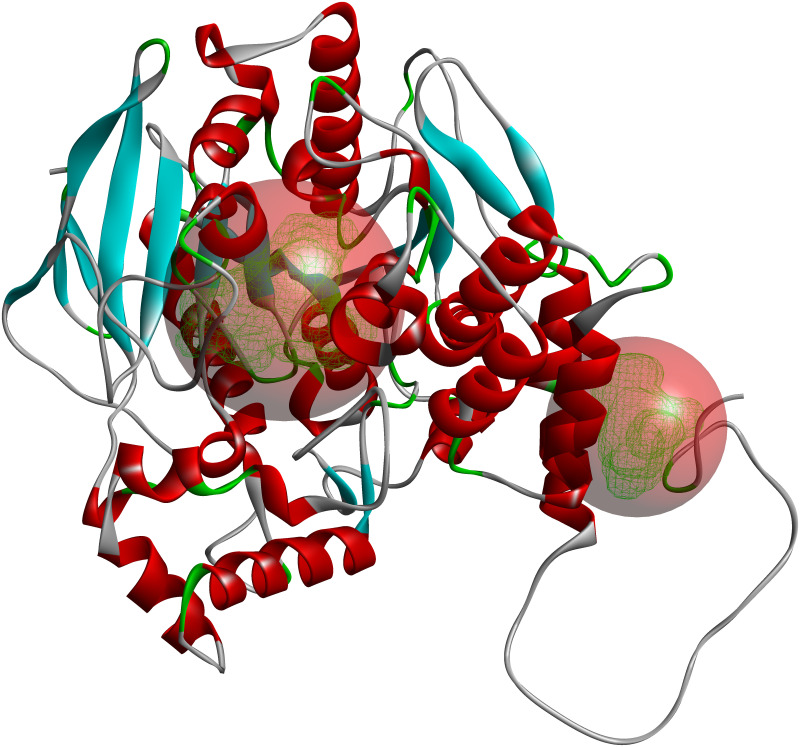
Two major binding sites found for AChE.Other, smaller sites are not shown.